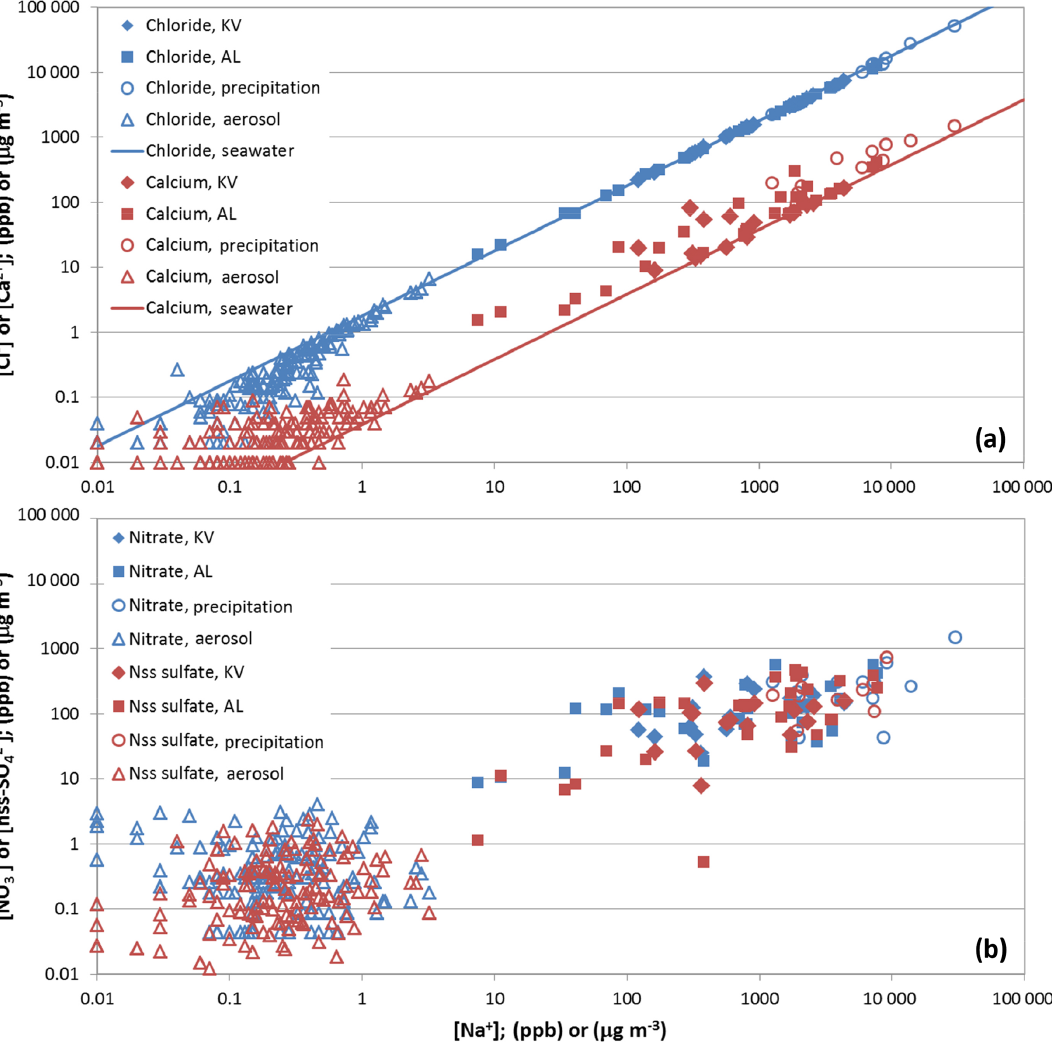
Figure 6. (a) Chloride (blue) and calcium (red) concentrations vs. sodium concentrations in snow pit KV (filled diamonds) and AL (filled squares), in precipitation (open circles), and aerosols (open triangles). Aerosol concentrations (µgm − 3 ) are derived from measurements at Zeppelin Station. The lines indicate the standard seawater ratio. (b) Same as top, but for nitrate (blue) and nss sulfate